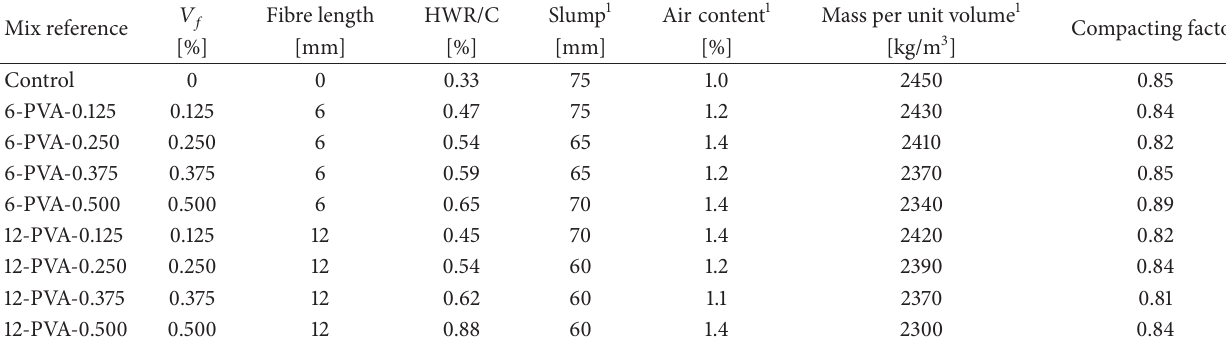
Table 5: Fresh properties of FRC and